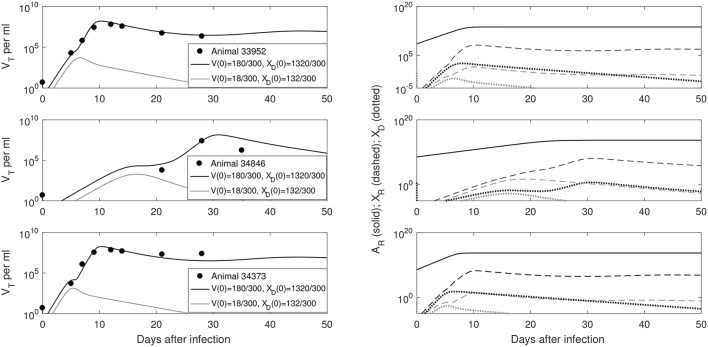
(Left) VT given by (6) vs. data; (Right) Free antibody (solid lines), recipient immune complexes (dashed lines) and donor immune complexes (dotted lines): for V(0)+XD(0) = 1500/300 vRNA copies per ml, XD(0)/V(0) = 7.8 (black) and V(0)+XD(0) = 150/300 vRNA copies per ml, XD(0)/V(0) = 7.8 (gray). Note that antibody populations are identical regardless of initial conditions (solid black and gray lines overlap) but the immune complexes differ.